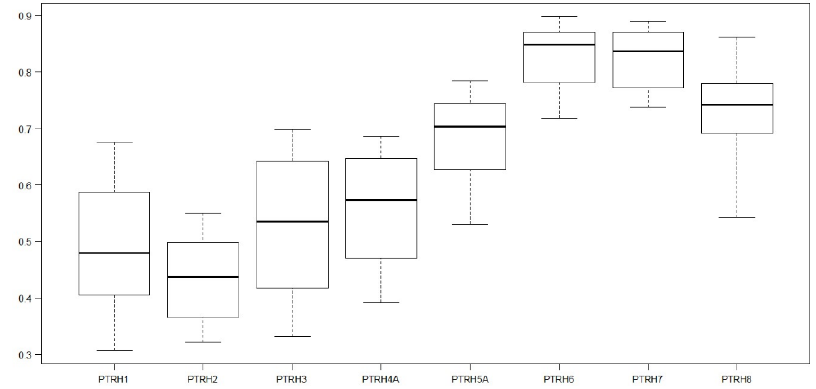
Figure 7. Boxplots: Evaporative indexes by RBD.